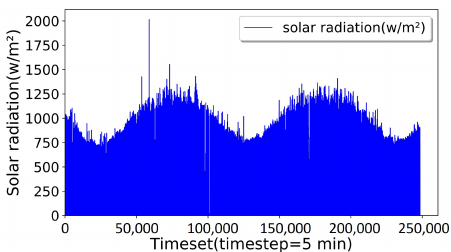
Figure 7. Recorded irradiation variation over 2 years (W/m²).